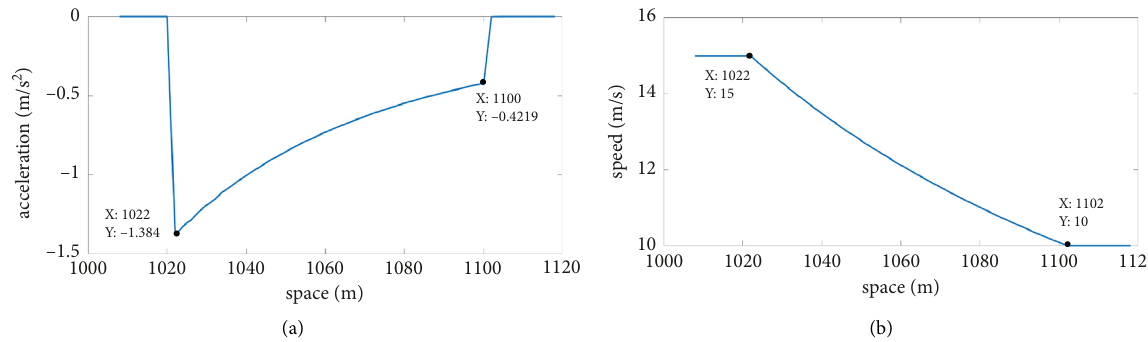
Figure 9: Speed and acceleration inside the “buffer zone”: (a) acceleration; (b)